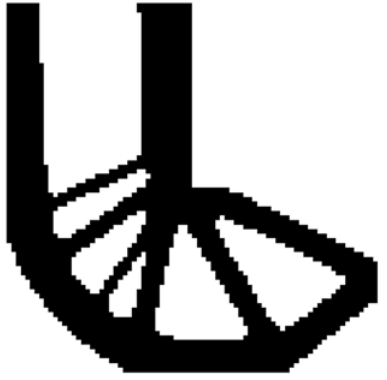
Figure 10. Optimized shape of L-shaped by traditional BESO.